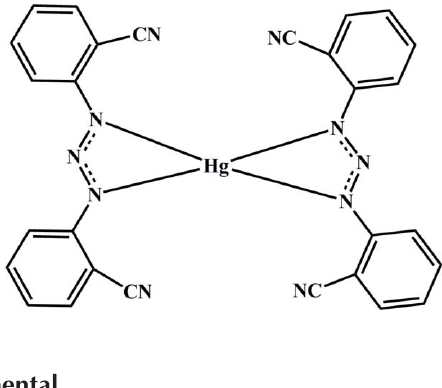
Bruker APEXII CCD area-detector diffractometer